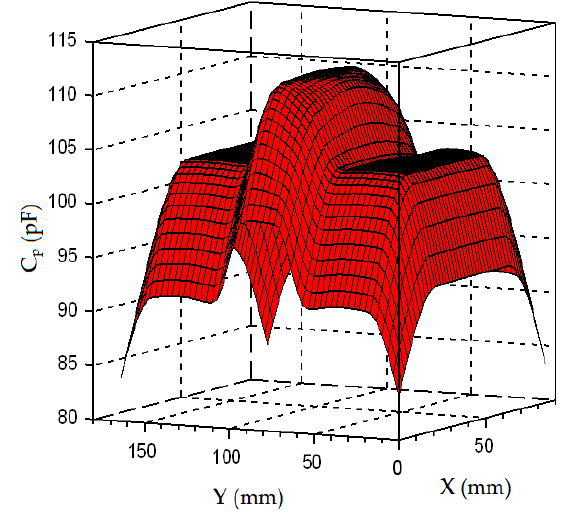
Figure 7. The 3D plot of the resultant parasitic capacitance C p as a function of the relative